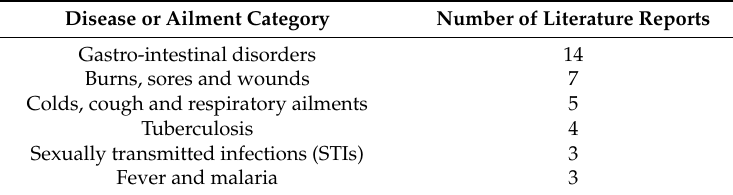
Table 2. Major disease or ailment categories